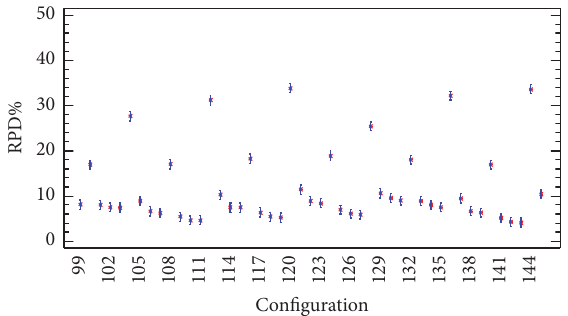
Figure 2: Means plot and Tukey’s HSD intervals at the 95% confidence level for 47 configurations of ILS